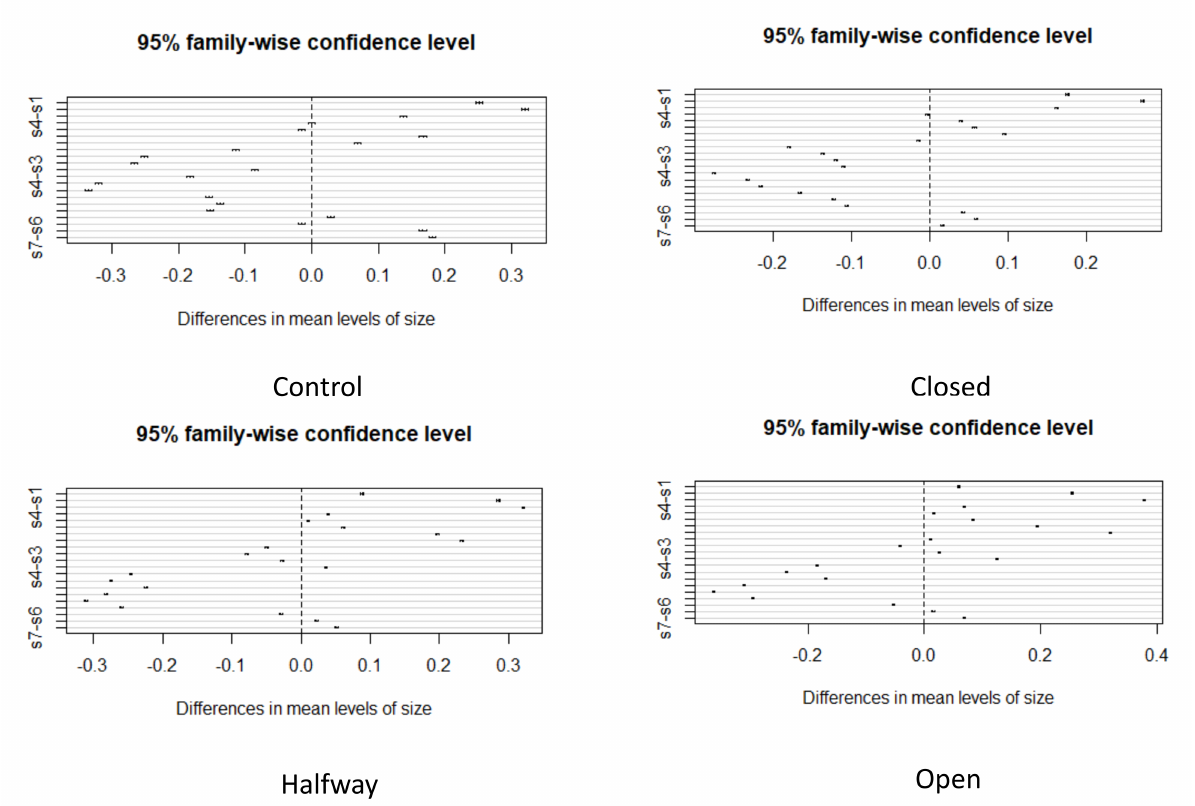
Figure 12. Family-wise confidence interval of proportion of sediment weights for different grain